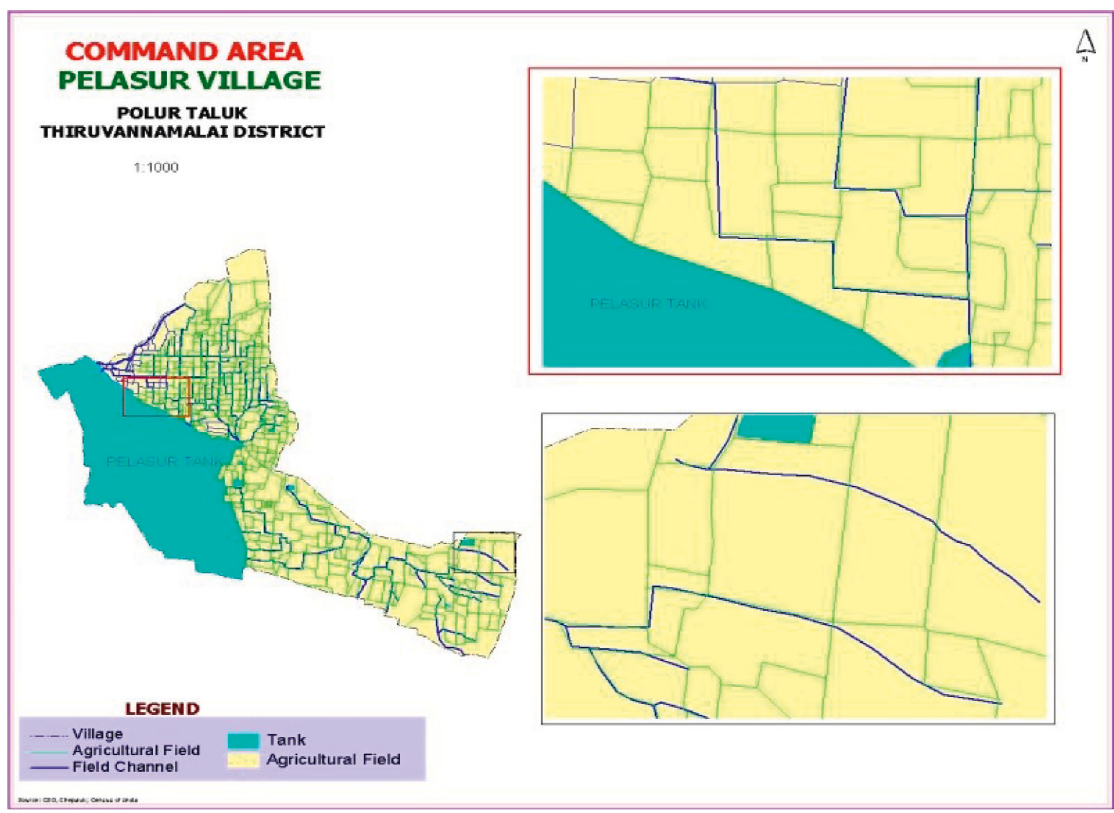
Figure 2: Command map of Pelasur Table 2: Size of Pelasur respondents’ landholdings by reach.